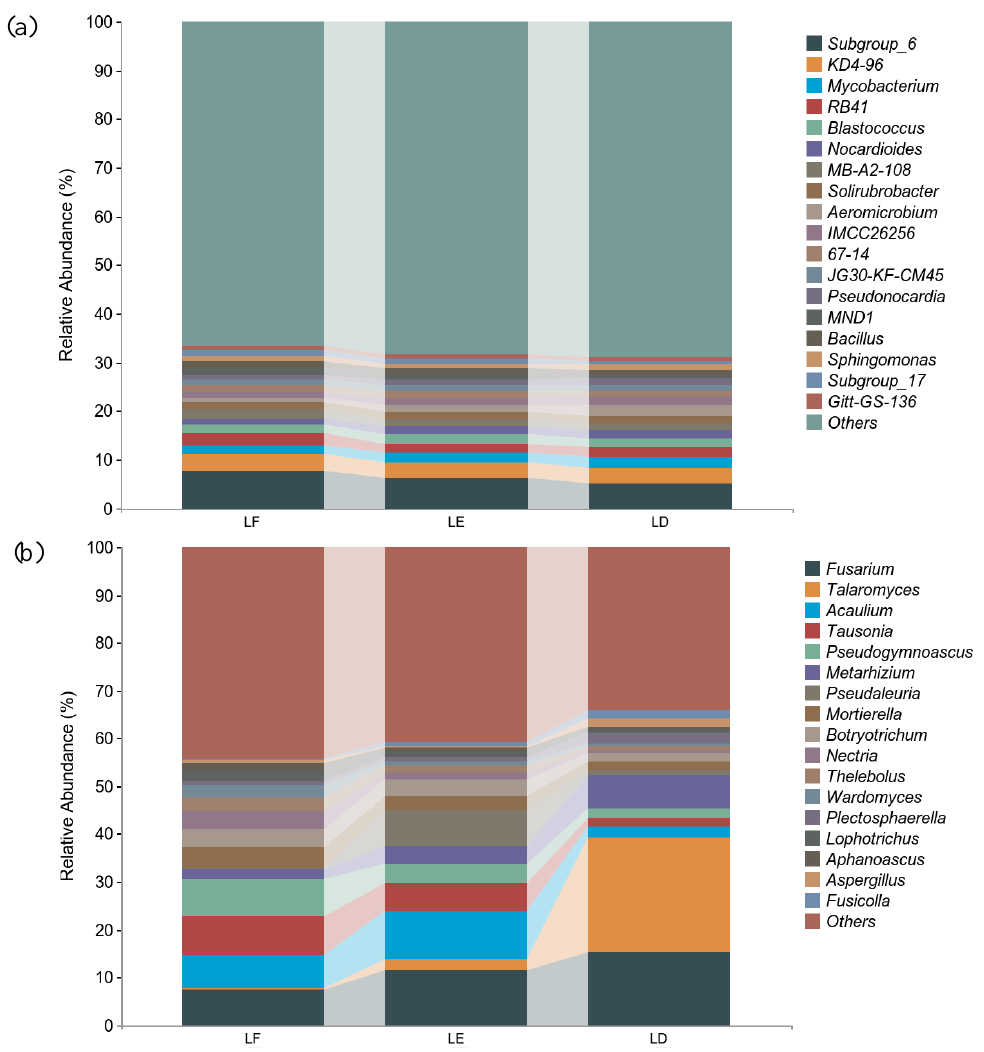
Figure 3. Relative abundance of bacteria and fungi at phylum in rhizosphere soil. ( a ): Relative abundance of bacterial genus-level species composition. ( b ): Relative abundance of fungal genus-level species composition. LF: Morus alba ; LD: Arachis hypogaea ; LE: Morus alba - Arachis hypogaea.